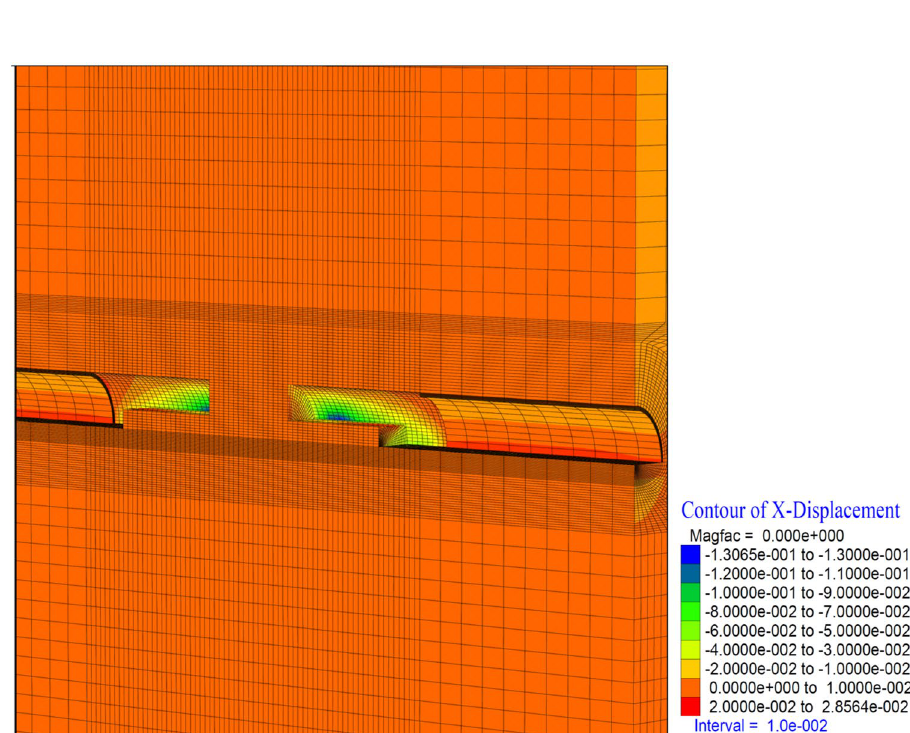
Figure 20. X displacement in stage